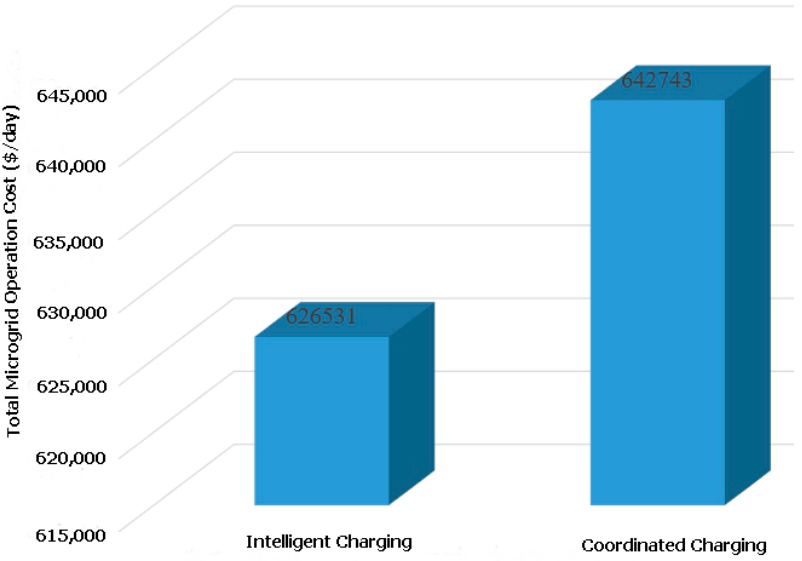
Figure 11. Comparative operation cost of the microgrid in the coordinated and intelligent charging patterns.